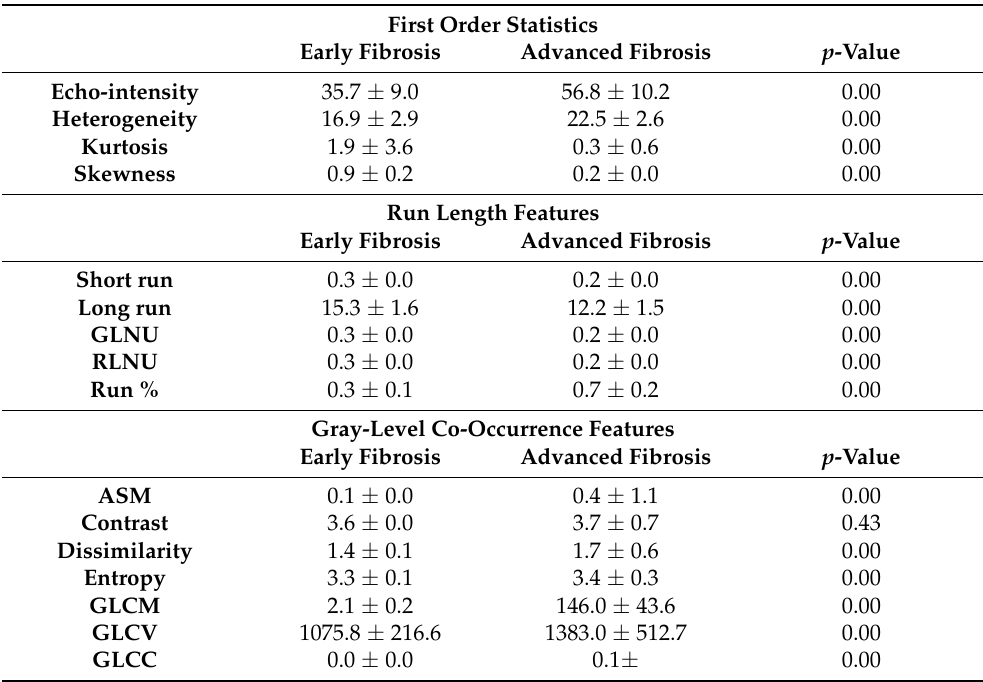
Table 1. The mean and standard deviation of the ultrasound texture features of early fibrosis com- pared to advanced liver fibrosis. GLNU: gray-level nonunformity; RLNU: run length nonuniformity; ASM: Angular second momentum; GLCM: gray level mean; GLCV: gray level variance; GLCC: gray level correlation.